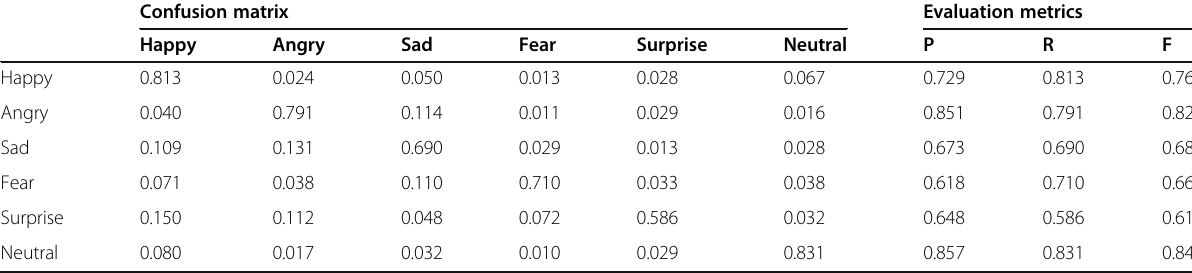
Table 1 Performance analysis of trained emotion classification model Confusion matrix Evaluation metrics